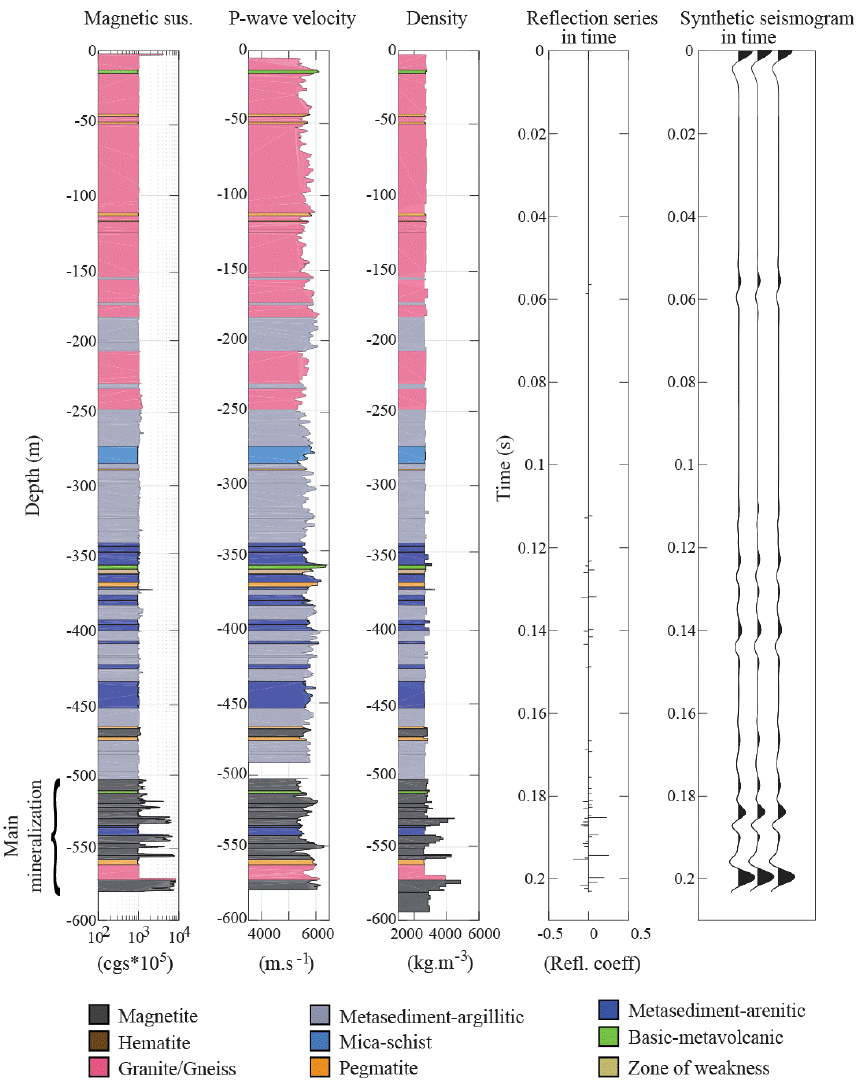
Figure 2. Downhole geophysical logs, theoretical reflection coefficients, and synthetic seismograms from the host rock and the main miner- alization (from Maries et al.,